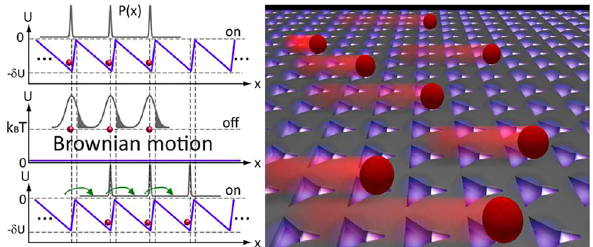
Figure 8: Brownian Ratchet. Left side image: Brownian motion can be rectified in the forward direction by the on–off modulation of a spatially asymmetric external potential. Blue and grey lines indicate potential and probability distribution, respectively. Right side image: schematic illustration of the Brownian ratchet principle where the motion of particles is determined by the asymmetric, modified triangular holes. Figures reproduced with permission from [160], Copyright 2016 ACS